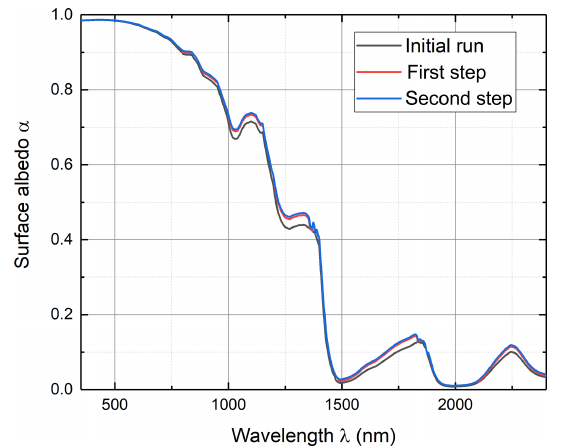
Figure 4. Spectral surface albedo of snow for cloudless conditions and a SZA of 60 ◦ for different SSA and BC particle mass concen- trations. The inlay shows an enlargement of the spectral albedo be- tween 350 and